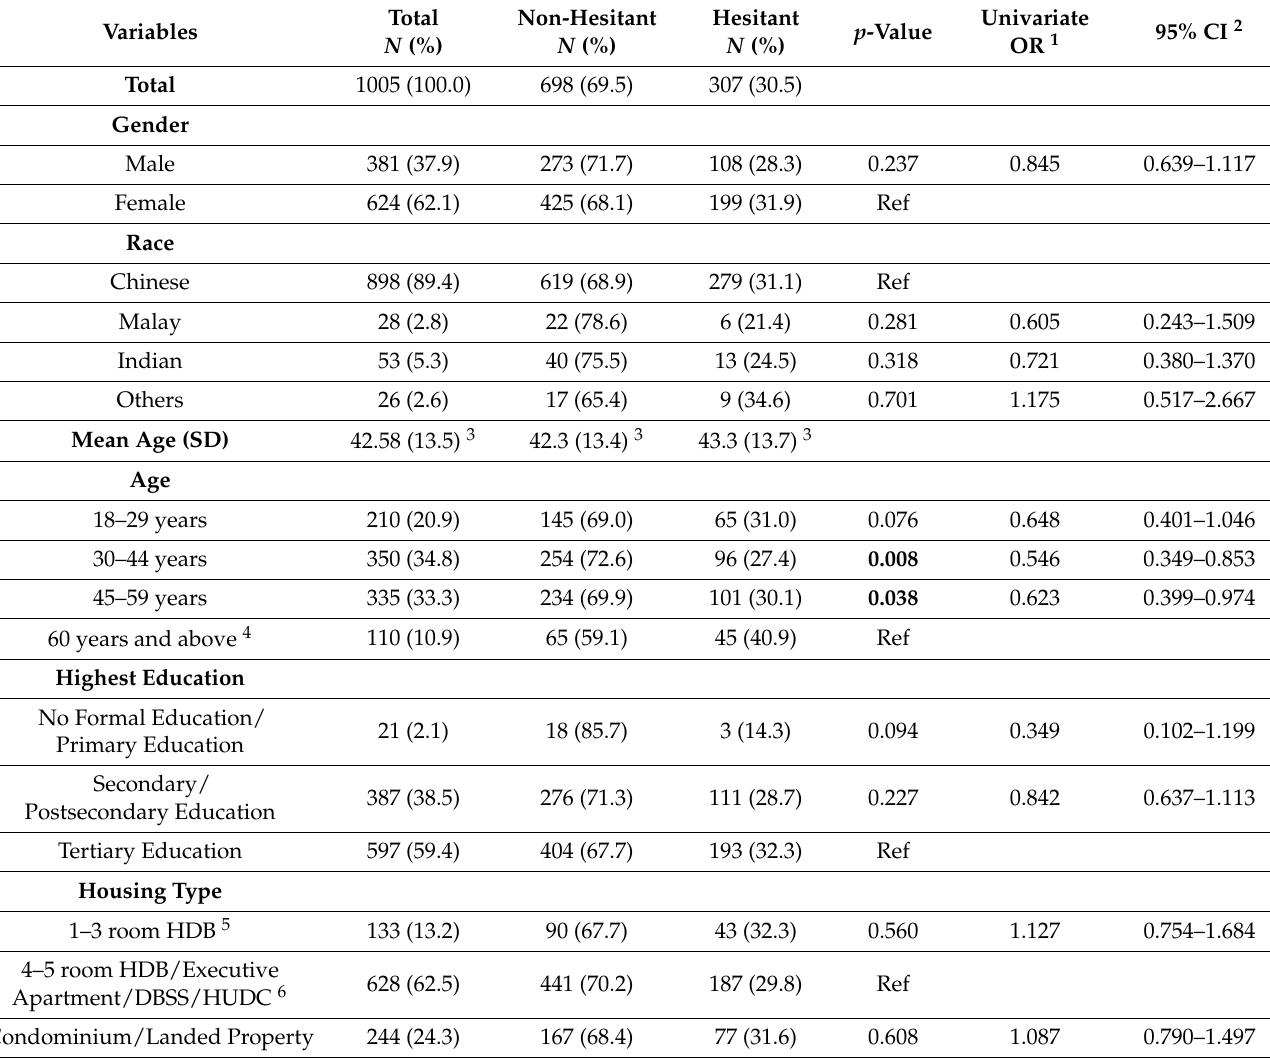
Table 1. Sample characteristics of participants ( N = 1005) and univariate analyses of sociodemo- graphic, mental distress, and benefits/concerns differential categorical variables as a function of booster vaccine